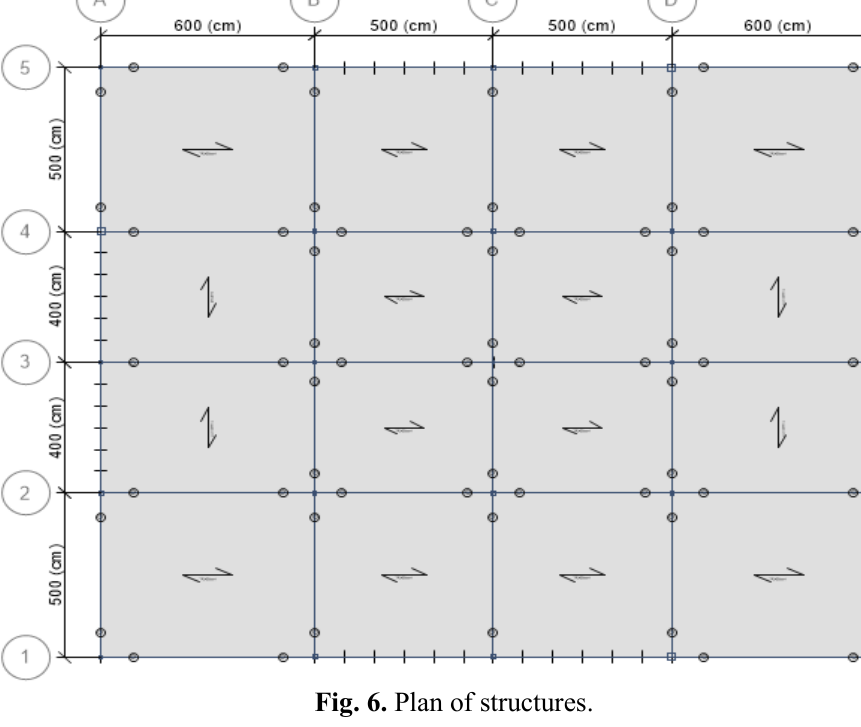
Fig. 6. Plan of structures.